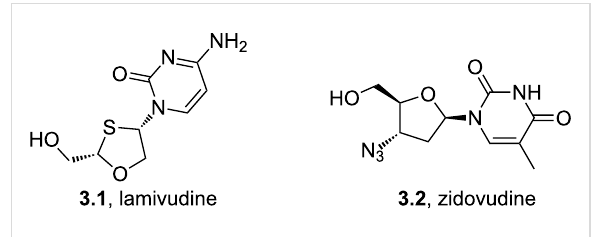
Figure 9: Structures of lamivudine and